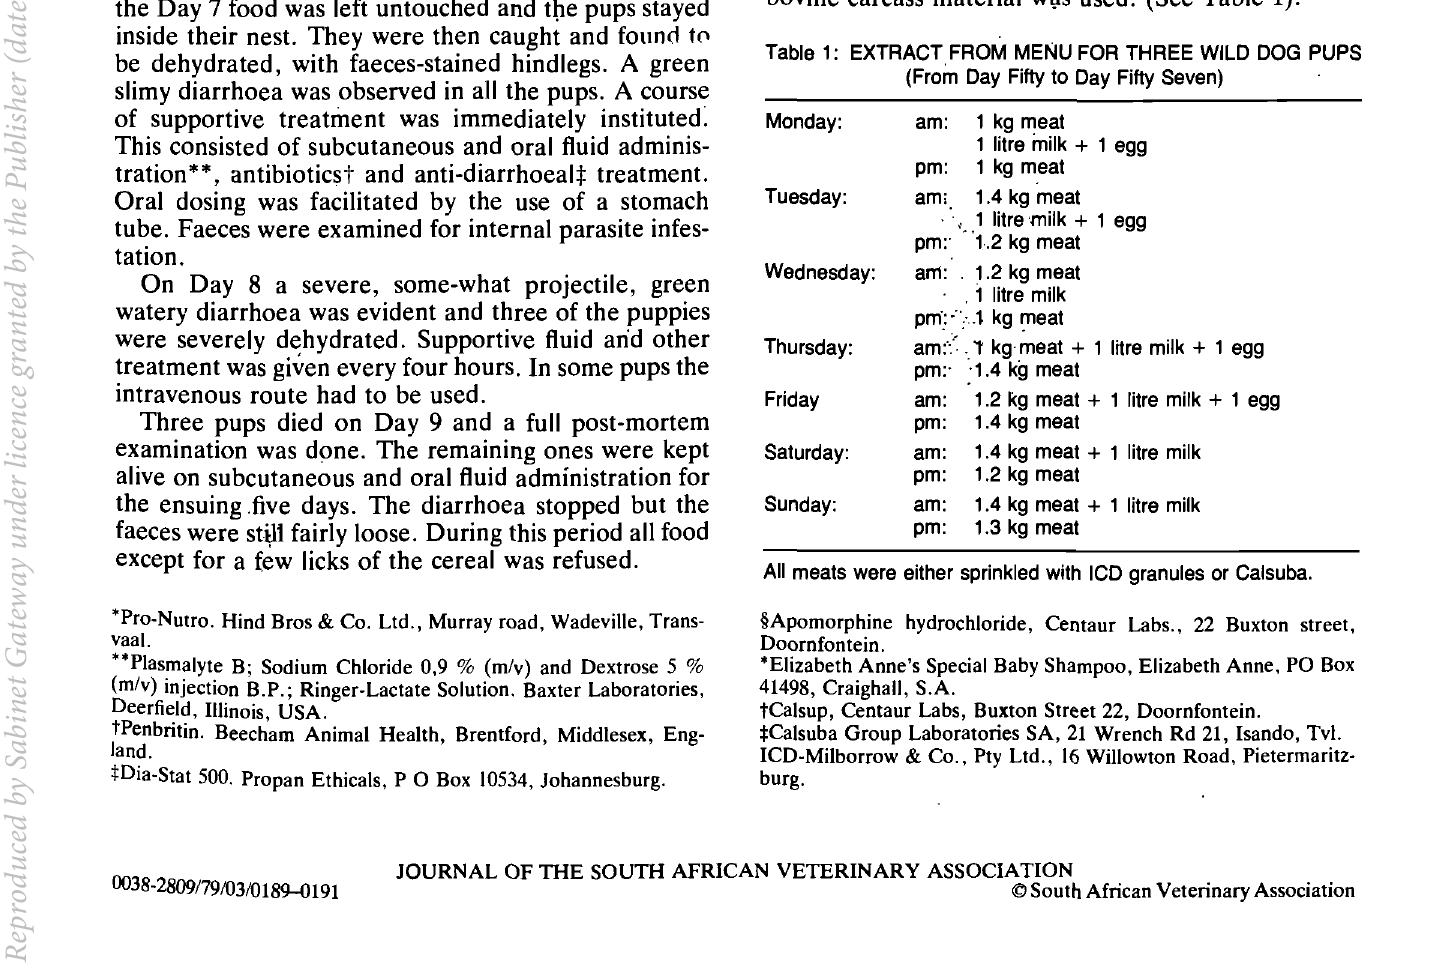
Table 1: EXTRACT FROM MENU FOR THREE WILD DOG PUPS (From Day Fifty to Day Fifty